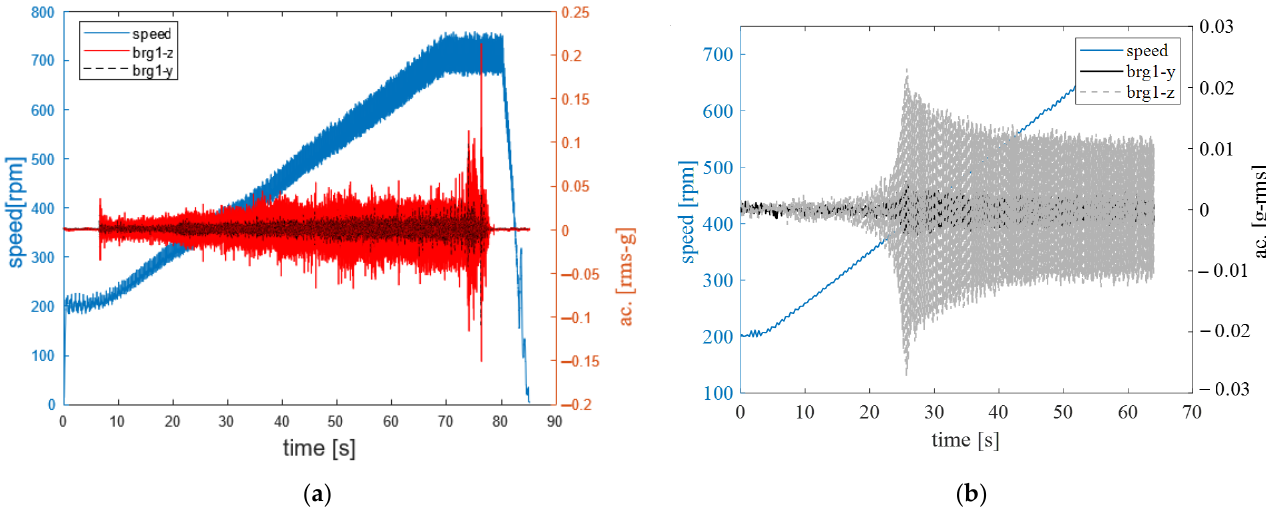
Figure 15. Measurement data for bearing 1 at test-b, ( a ) raw measurement data, ( b ) after synchronizing the tachometer data and acceleration data.